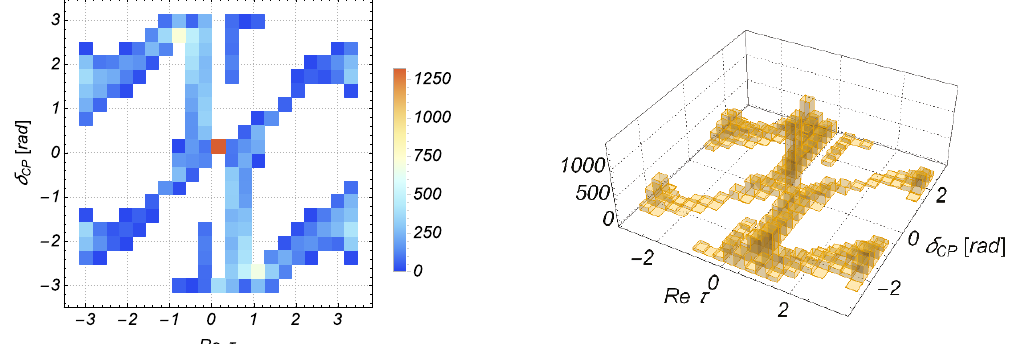
Figure 4 . Distributions of the CP-violating phase δ CP vs. real part of complex structure modulus Re τ for Im τ = 1 . 8 in Pattern I.